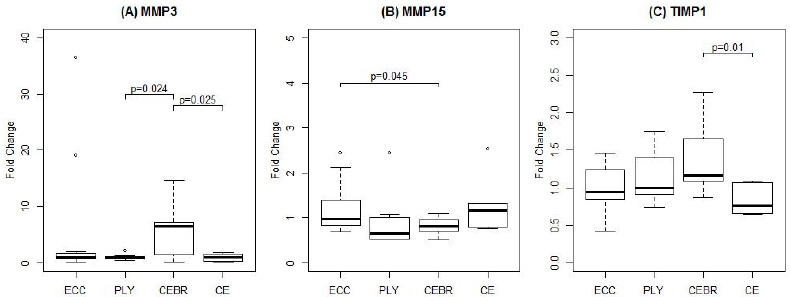
Figure 1. Changes in gene expression six hours after a single bout of unilateral eccentric (ECC, n = 13), plyometric (PLY, n = 12), concentric-eccentric exercise followed by foam rolling (CEBR, n = 12) and conventional concentric-eccentric (CE, n = 12) resistance exercise. Fold-changes were calculated with respect to the untrained limb. Brackets indicate significant between-group differences. Outliers, defined as data points located outside 1.5 times the interquartile range above the upper and below the lower quartile, are indicated by open circles.